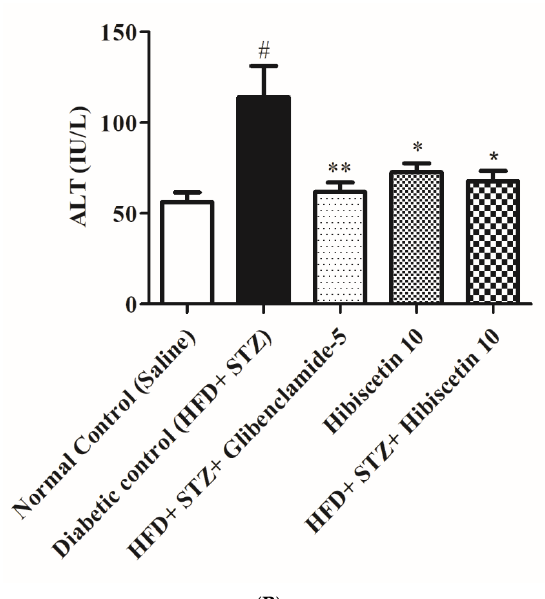
Figure 7. ( A , B ) Effect of hibiscetin on AST and ALT (n = 6). The mean SEM is used to express the data; ( # p < 0.05) saline vs. HFD+STZ; (** p < 0.01, and * p < 0.05) HFD+STZ vs. treatment group.